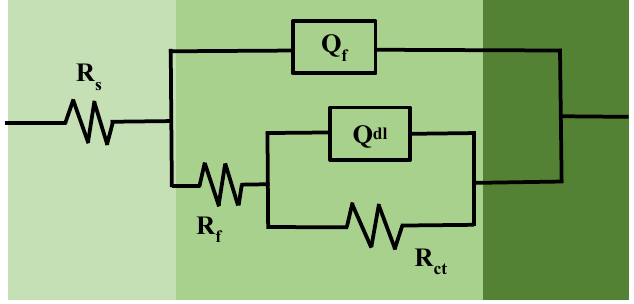
Figure 8. The equivalent electrical circuit of the 35CrMoV steel in 3.5 wt% NaCl solution. Materials 2019 , 12 , x FOR PEER REVIEW